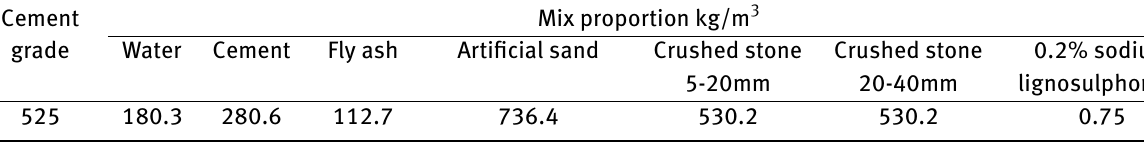
Table 1: Concrete mix proportion